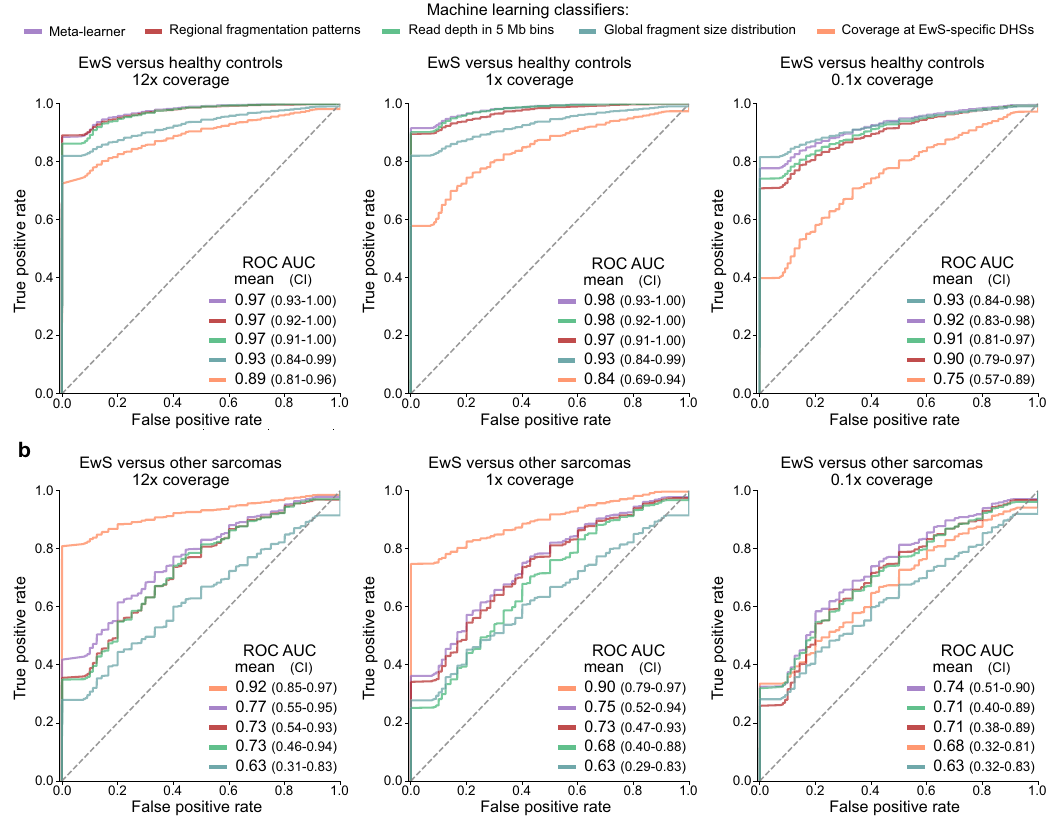
Fig. 6 Fragment-based analysis of cfDNA enables accurate tumor detection and classi fi cation. Prediction performance of machine learning classi fi ers trained to distinguish patients with EwS from healthy controls ( a ) and from patients with other pediatric sarcomas ( b ), based on the following sets of input features: global fragment-size distribution (blue); fragment coverage at EwS-speci fi c DHSs (orange); read depth in 5 Mb bins (green); and regional fragmentation patterns (red). Results are also shown for a meta-learner combining the predictions of all individual classi fi ers into a weighted consensus prediction (purple). The performance of each model was evaluated by and averaged over 100 iterations of bootstrapping, separately for the different sequencing coverage levels (median of 12×, 1×, and 0.1×). CI is the 95% con fi dence interval obtained by bootstrapping. a ROC curves show, for each feature set, the performance for distinguishing between cfDNA samples from patients with clinical evidence for EwS ( n samples = 103) and healthy controls from three independent sets (22 controls sequenced in this study; 22 controls from Cristiano et al. 32 ; and 24 controls from Ulz et al. 34 ). Machine learning models were trained separately for each of the 3 control sets; the mean results over the 3*100 bootstrap iterations are shown. b ROC curves show the performance of each feature set for distinguishing between cfDNA samples from patients with EwS ( n samples = 98) and from patients with other pediatric sarcomas ( n samples = 18). For both sets of samples, we ensured the presence of tumor-derived cfDNA in the blood based on genetic